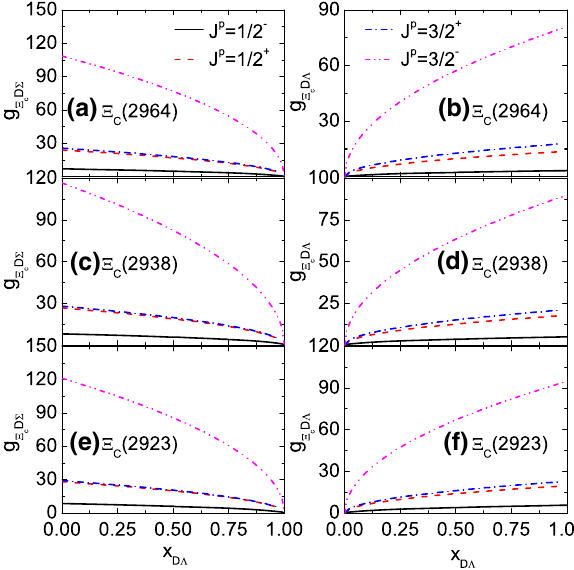
Fig. 3 Thecouplingconstantsofthe (cid:2) ∗ c statewithdifferent J P assign- ments as a function of the parameter X D (cid:3) . And the X D (cid:3) is the proba- bility to find the (cid:2) ∗ c in the hadronic state D